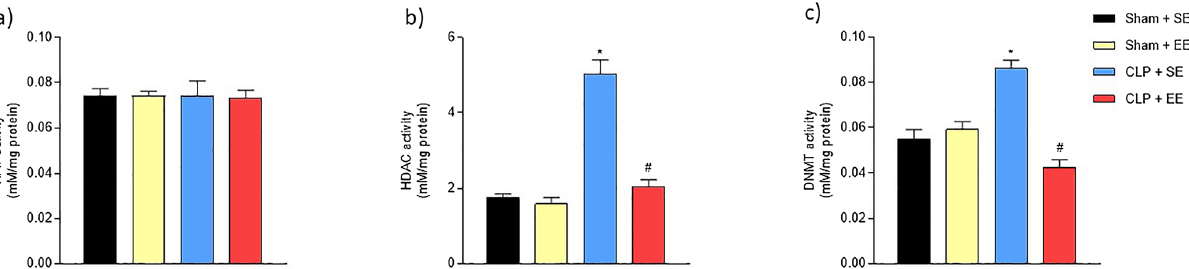
Figure 6. Effects of environmental enrichment on the activity of epigenetic enzymes in the hippocampus of animals subjected to sepsis. HDAC, HAT and DNMT activities were measured in the hippocampus of animals submitted to sepsis after the EE protocol (40-day period). HAT ( a ); HDAC ( b ) and DNMT ( c ). The data were expressed as mean ± SD and compared with one-way analysis of variance (ANOVA) followed by the Tukey test. nº = 6 each group. * p < 0.05 versus Sham + SE; # p < 0.05 versus CLP + SE. EE: environmental enrichment; SE: